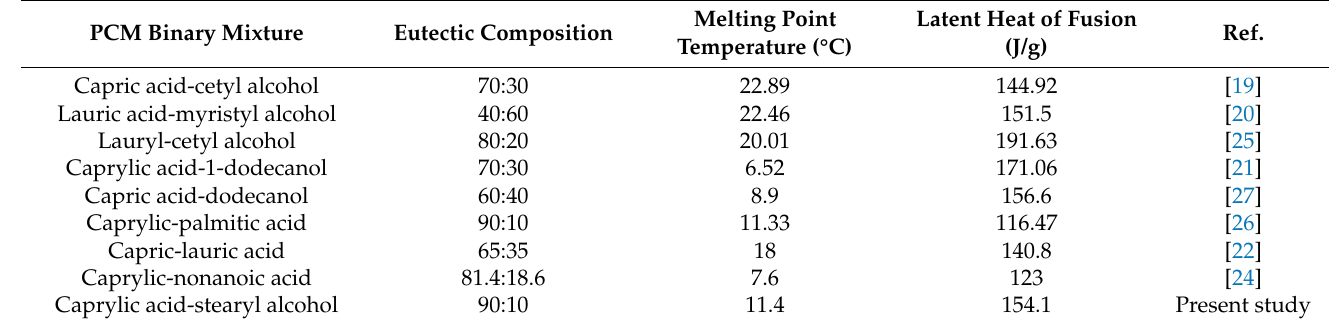
Table 1. Summary of PCM binary mixture reported for cooling application.